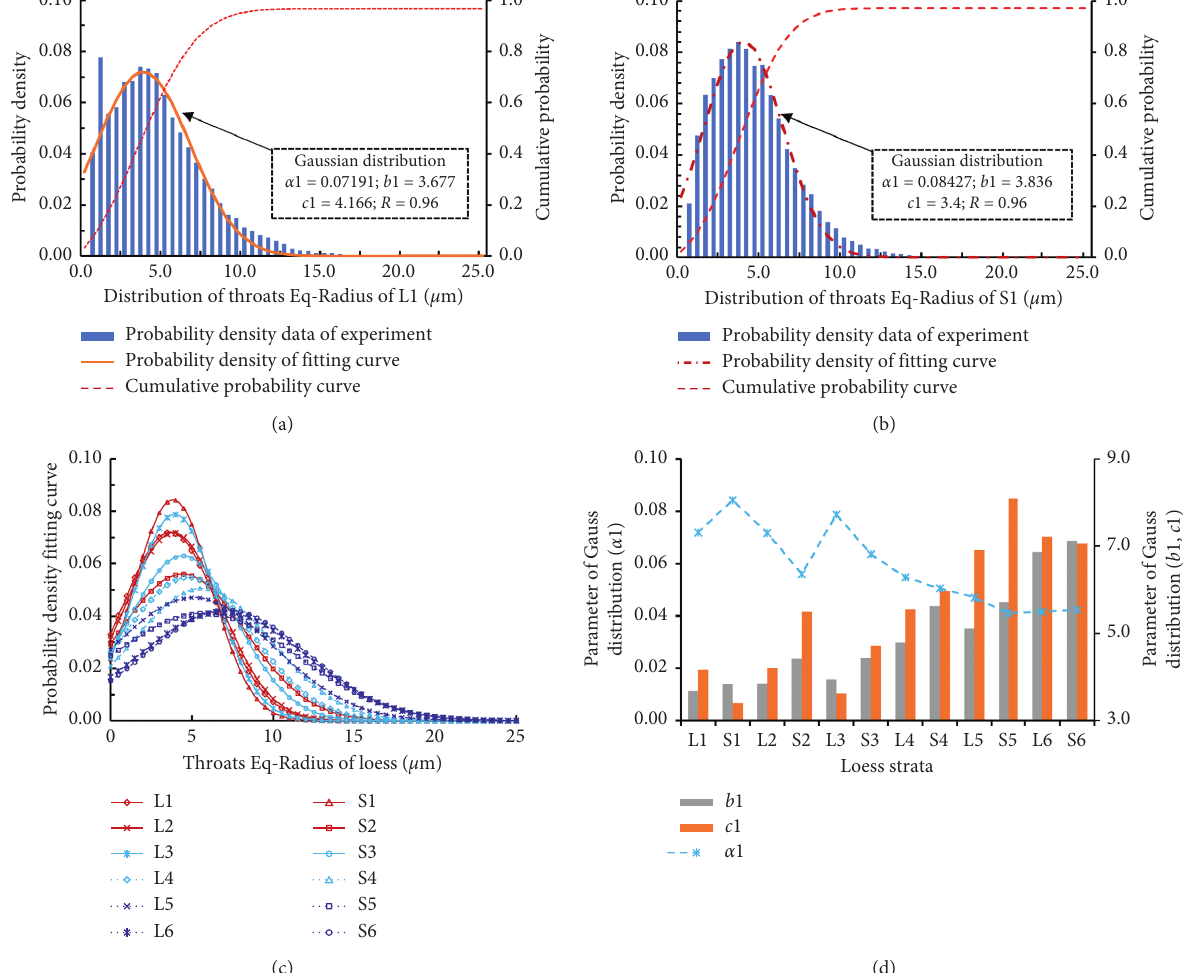
Figure 9: Eq-Radius of loess throats: (a) probability density versus throat Eq-Radius of L1; (b) probability density versus Eq-Radius of S1; (c) distribution characteristics of Eq-Radius for various layers; (d) variation in fitting parameters for various layers of